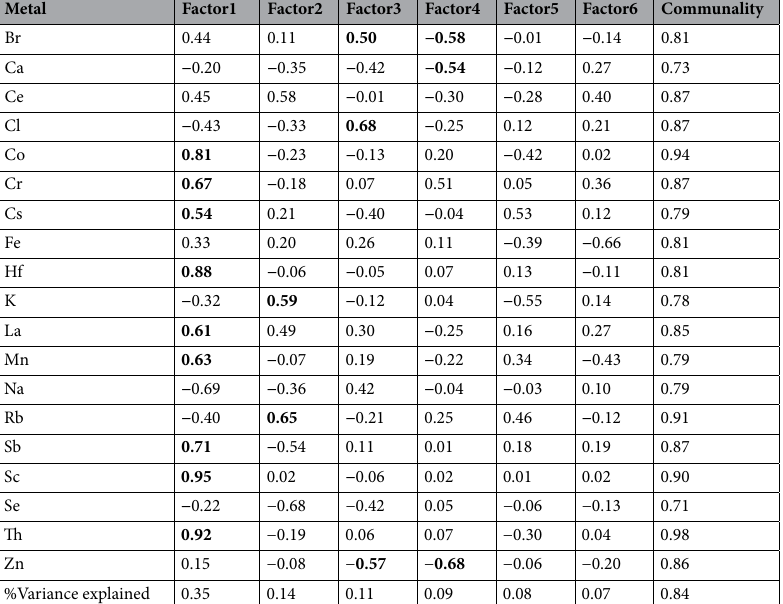
Table 3. Rotated factor loadings. Values greater than 0.5 are highlighted in bold. The percentage of total variance explained by each factor is also presented in the table.